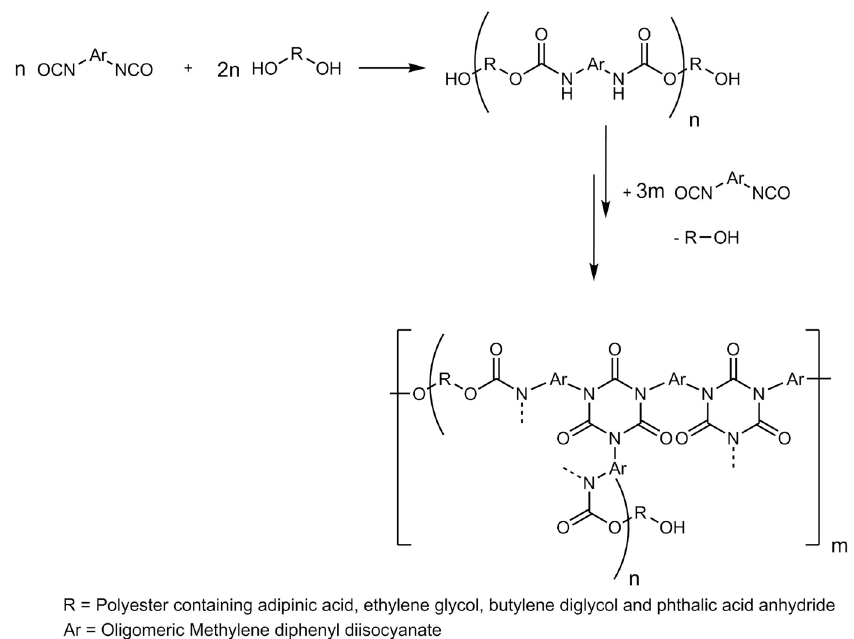
Figure 2. Formation of the polyurethane / polyisocyanurate (PUR / PIR) structures in the foams with the used formulation.